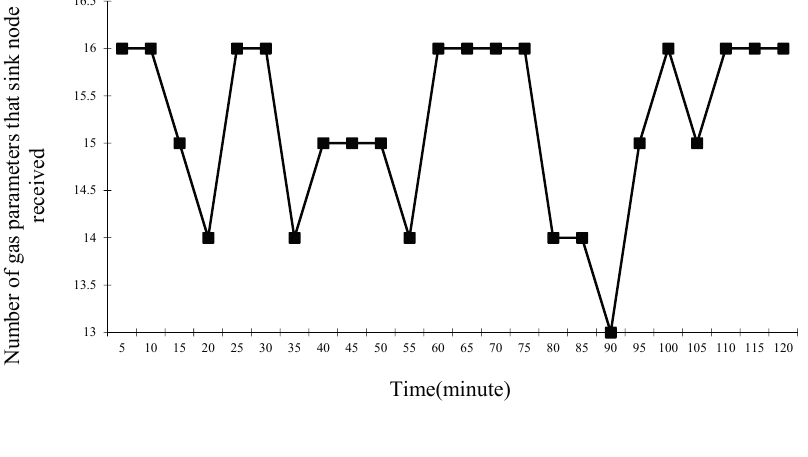
Figure 6. Statistics of each parameter in the laboratory environment. ( a ) Statistics of gas parameters; ( b ) Statistics of temperature parameters; ( c ) Statistics of humidity parameters; ( d ) Statistics of random